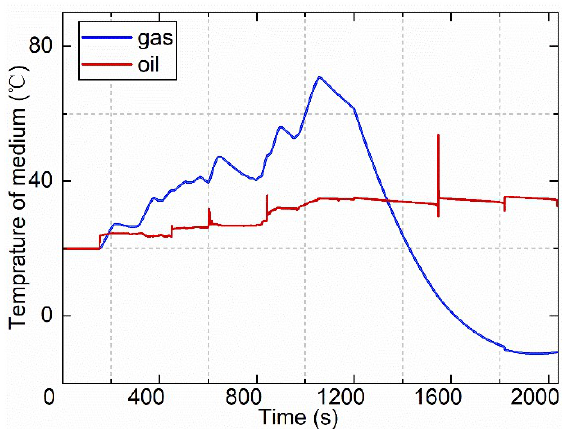
Figure 9. Temperature of hydraulic oil and gas.